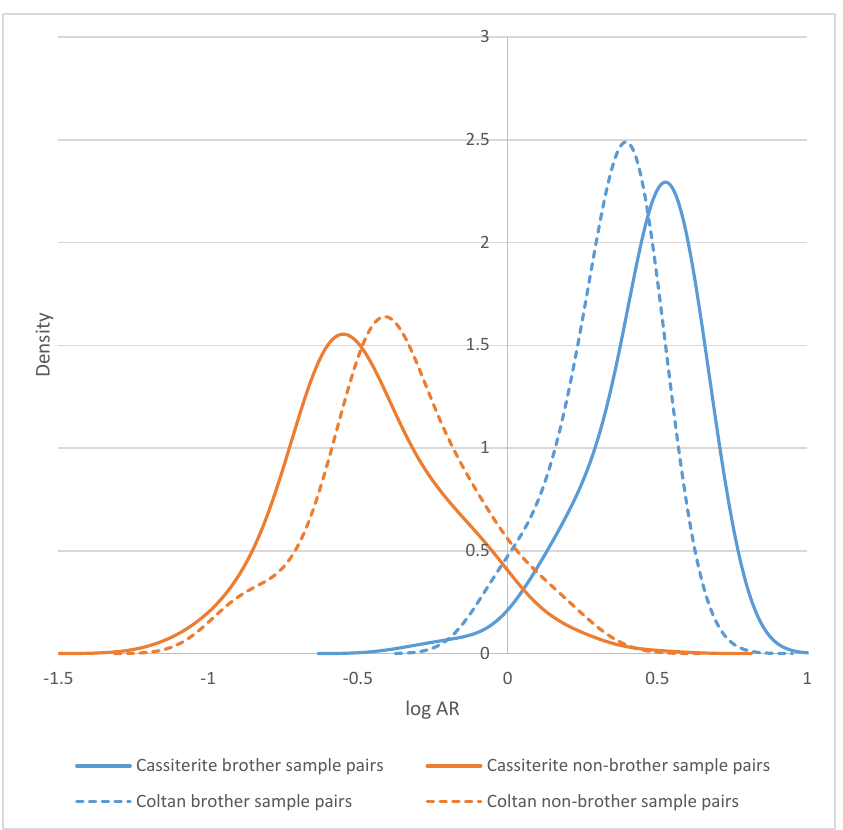
Figure 3. Distributions of log area ratios (log AR) for brother and non-brother sample pairs.